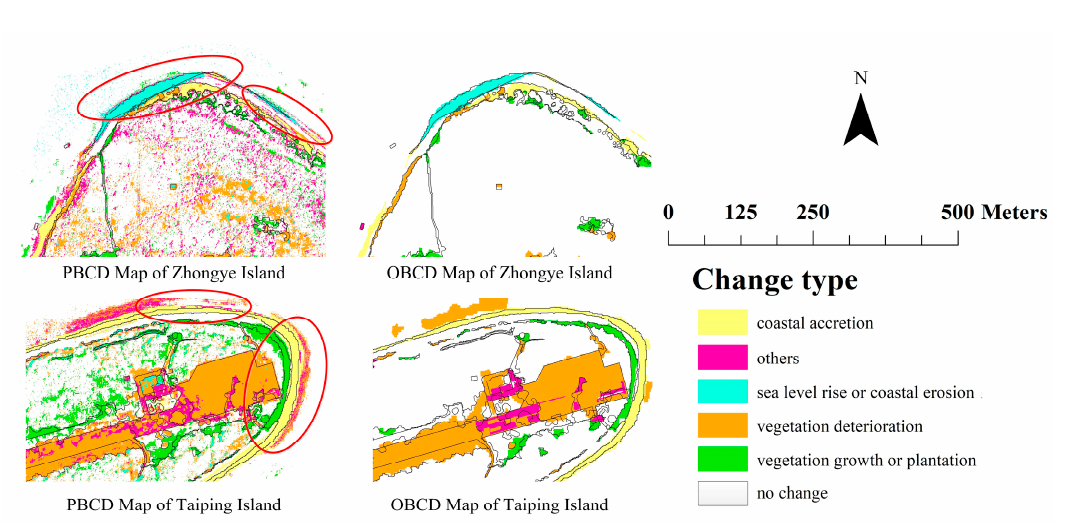
Figure 7. The impact of registration error on PBCD and OBCD change detection methods. (Pixels between neighboring segments were marked by red circle in PBCD change detection maps).